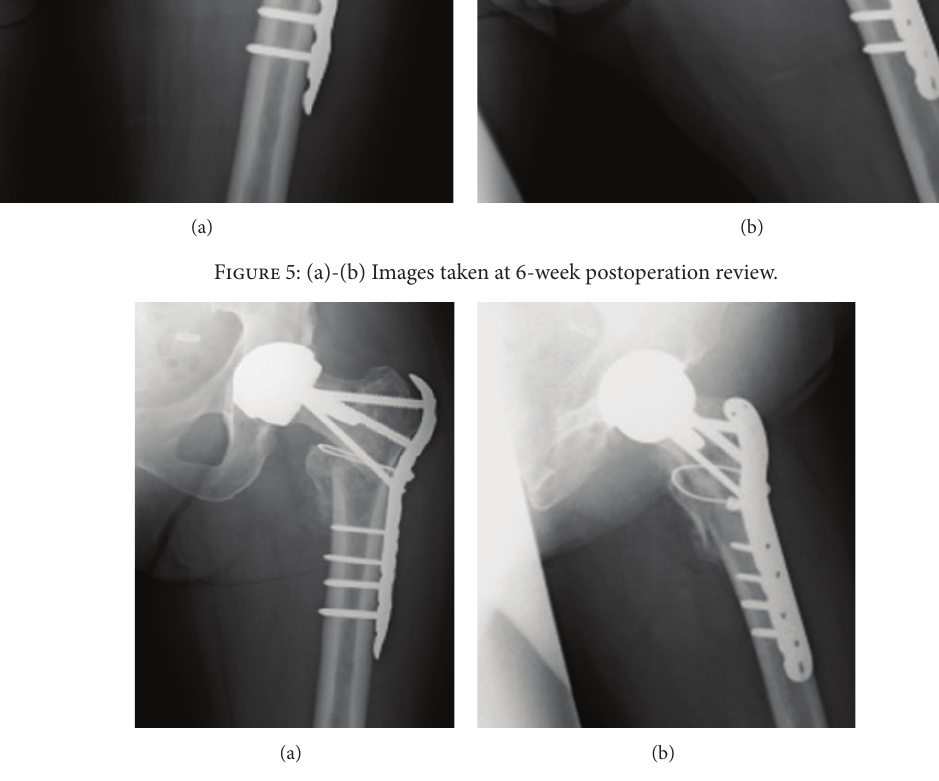
Figure 6: (a)-(b) Radiographs from 12 weeks after operation.